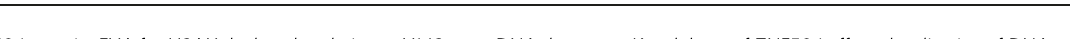
Fig. 3 ZNF506 recruits EYA for H2AX dephosphorylation at Y142 upon DNA damage. a Knockdown of ZNF506 affects localization of DNA repair proteins to the DNA double-strand break site. b ZNF506 regulates H2AX dephosphorylation upon DNA damage. c DNA damage induces interaction between ZNF506 and EYA1. d , e , ZNF506 is required for the recruitment of EYA1 to DNA double-strand break sites. Cells were exposed to 2 Gy irradiation (IR) and stained for EYA1 focus formation (red). Nucleus is stained with DAPI (blue). d Quanti fi cation of EYA1 foci in U2OS cells after the indicated treatment. e Representative images of EYA1 foci in U2OS cells. f Phosphorylation of EYA3 is required for its interaction with ZNF506. Either wild-type (WT) or the phosphorylation mutant of EYA3 (S219A) were expressed in HEK293 cells. Cells were exposed to 10 Gy IR and co-immunoprecipitation was performed. g The zinc- fi nger domain of ZNF506 is critical for its interaction with EYA1. The indicated FLAG-tagged constructs of ZNF506 (WT: wild-type; Δ KRAB: deletion of KRAB domain; and Δ ZN: deletion of zinc- fi nger domains) were expressed in HEK293 cells in which the endogenous ZNF506 had been knocked out using CRISPR. Cells were exposed to 10 Gy IR. Lysates were collected after an hour, co-immunoprecipitation was performed, and blots were probed with the indicated antibodies. h The zinc- fi nger domain of ZNF506 is critical for its role in H2AX dephosphorylation at Y142. The indicated HA-tagged constructs of ZNF506 (WT: wild-type and Δ ZN: deletion of zinc- fi nger domains) and FLAG-tagged H2AX were expressed in HEK293 cells in which the endogenous ZNF506 had been knocked out using CRISPR. Co-immunoprecipitation was performed. i Phosphorylation of ZNF506 is required for the interaction between EYA1 and MDC1. Shown are the representative data (mean ± SEM) from three independent experiments in a , d . ** p < 0.01 using ANOVA for vector vs. shRNA for each treatment condition (no IR or IR) in a , d . Representative images of three independent experiments are shown in e . Scale bars, 10 µ m. Representative western blots in b , c and f - i are provided from three biologically independent experiments. Unprocessed blots are provided in Supplementary Fig.